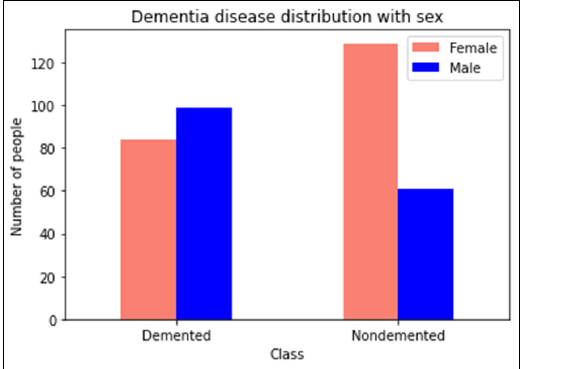
Fig. 2. Dementia disease distribution with gender among study participants